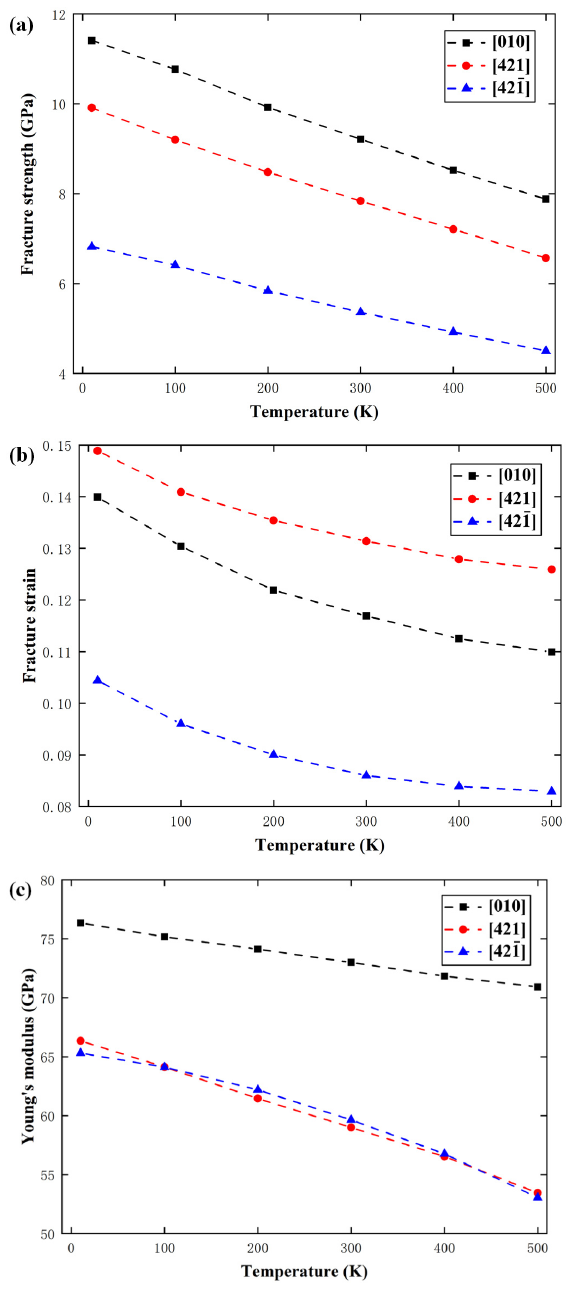
Figure 11. Variations of ( a ) fracture strength, ( b ) fracture strain, and ( c ) elastic modulus with tem- perature.